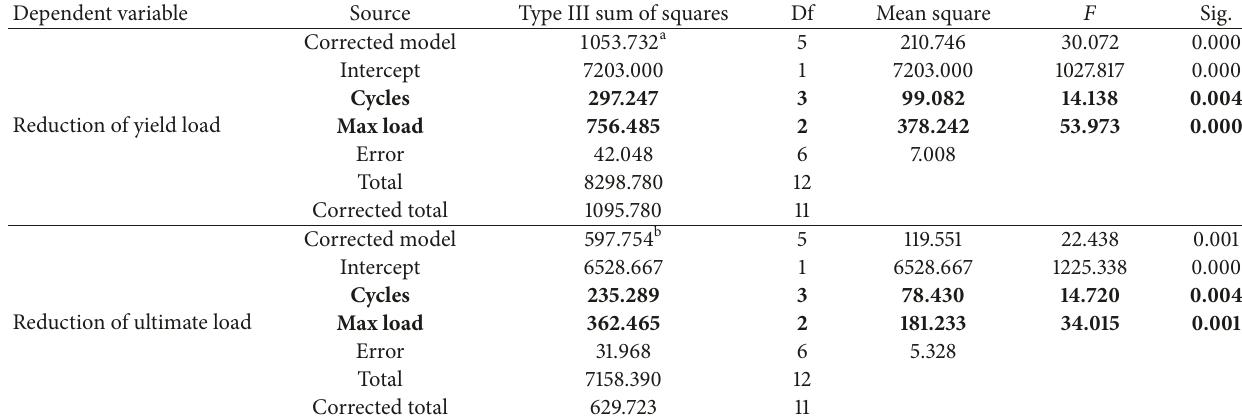
(a) Tests of between-subjects effects